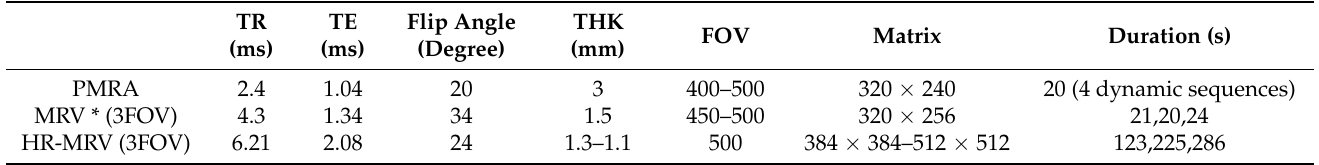
Table 1. Parameters used for pulmonary MR angiography and MR